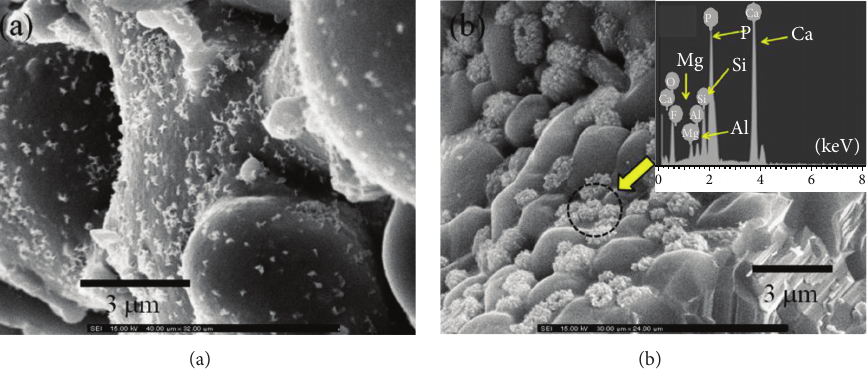
Figure 6: Surface microstructure of AW based glass sintered at 1100 ∘ C for 2h, after SBF immersion for 3 days at 37 ∘ C. (a) Area near the pores, scale bar 3 𝜇 m. (b) Area around the dense surface, scale bar 3 𝜇